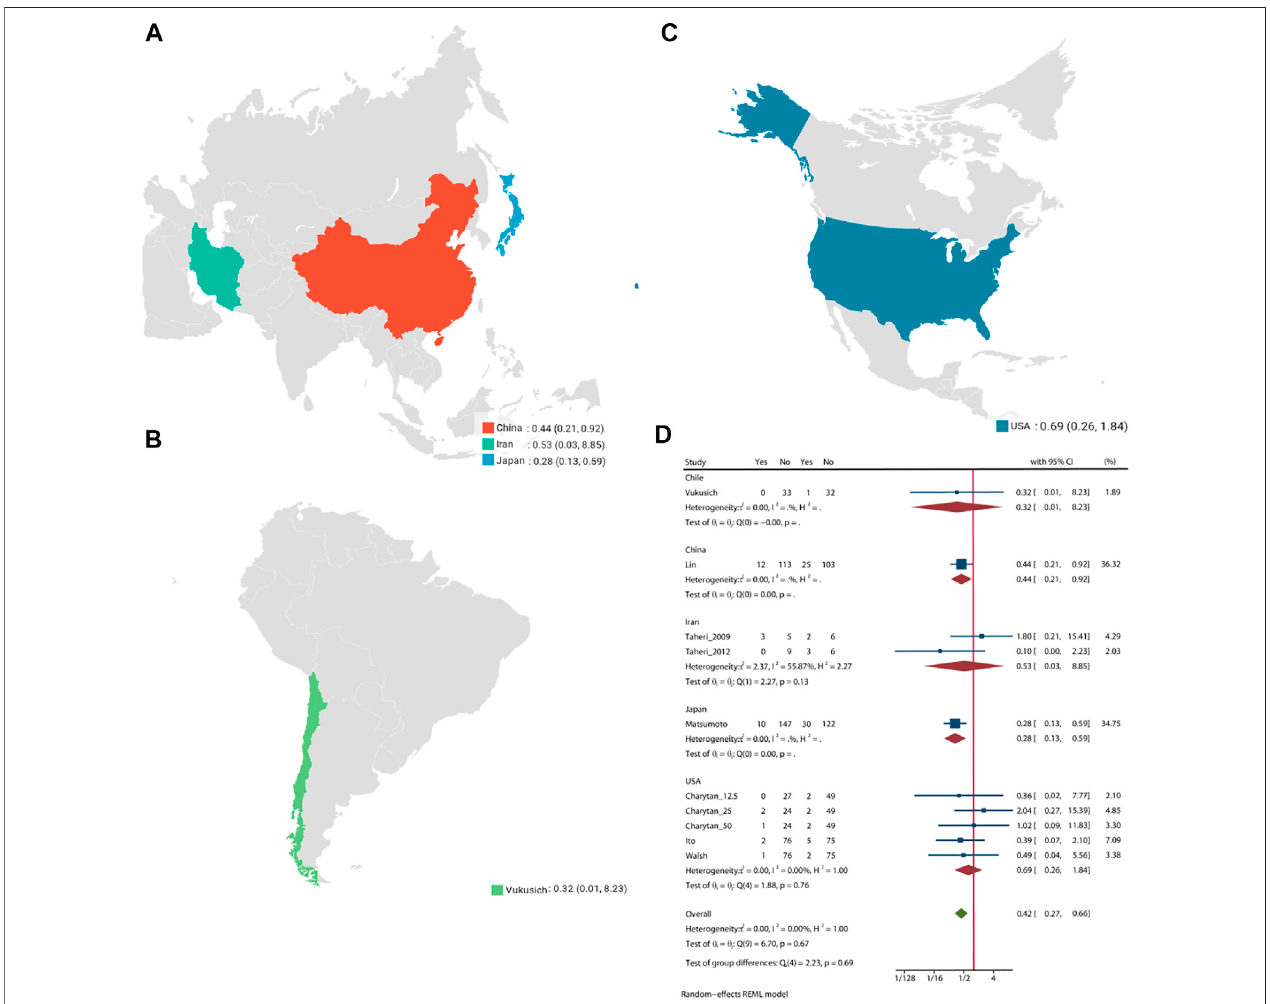
FIGURE 3 | Choropleth map of all-cause